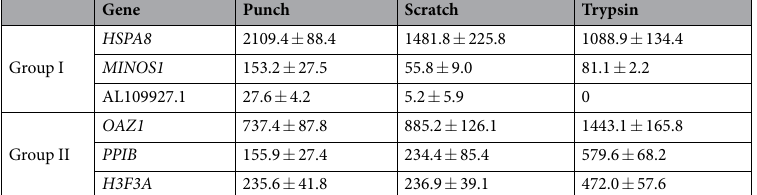
Table 1. Sampling method dependence of gene expression. The gene expression levels (TPM) for two groups obtained with the three different sampling methods are listed. Genes in groups I and II were expressed at a higher and lower level, respectively, in samples from the punching method than those obtained using the trypsin treated method. Besides above , Group I included C11orf98, BAG6, AATF, LIN7B, EVL, VPS13D, ARHGAP40, PRDM11 and NEURL1B . Group II included YBX1, PRR13, IMPDH2 PEBP1, XRCC5, CLPP, TAGLN2, FIS1, C19orf48, SEPT7, ARL16, TPM4, HNRNPK, SMARCE1, MALL, TRAM1, DARS,